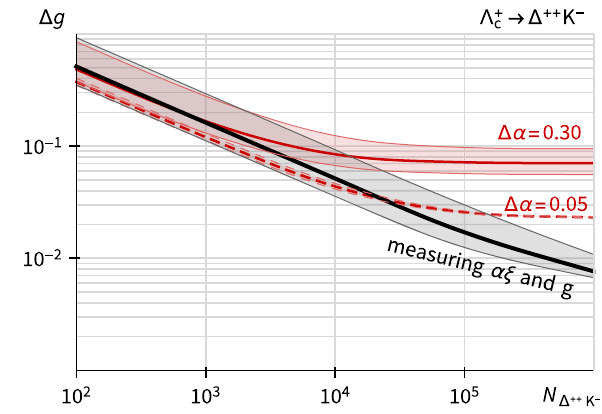
case when we measure αξ and g -factor simultaneously at current exper- iment. Calculation results for IR3 configuration. Margins represents the current uncertainly on a weak decay parameter